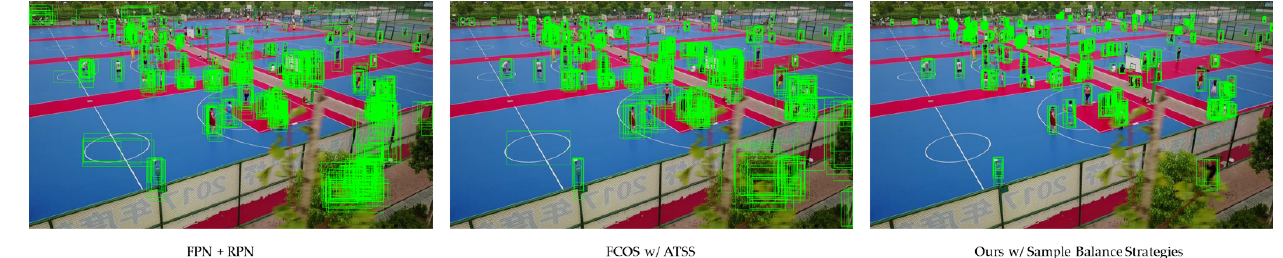
Figure 9. Comparative results of FPN+RPN, FCOS w/ATSS and our w/SBS method.